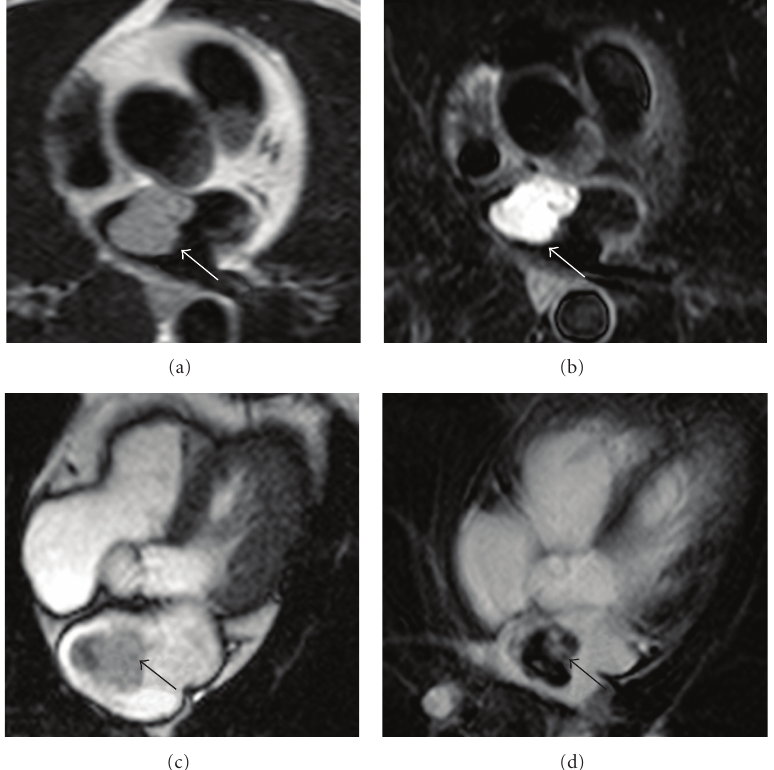
Figure 1: Left atrial myxoma. A lobulated mass is situated in the left atrium adjacent to the interatrial septum (a). On T2-weighted images, the mass appears uniformly high signal ((b), white arrow). Note that the mass is less well appreciated on bright blood cine imaging ((c), black arrow) and could be overlooked if it were smaller. Late gadolinium enhancement images (d) demonstrate patchy uptake of contrast within the mass (black arrow). The location and imaging characteristics are fairly typical for